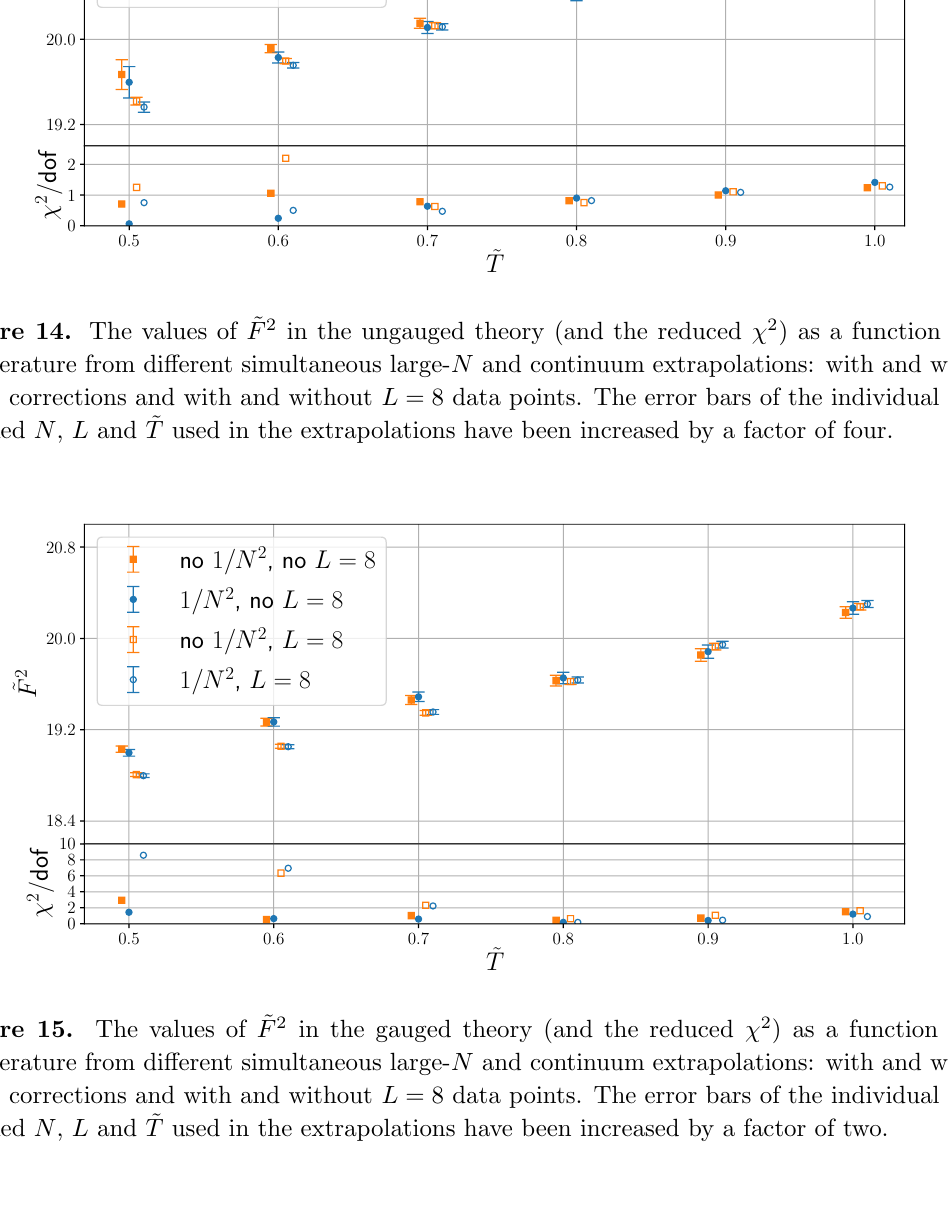
In the case of ~ R 2 , however, the N dependence is